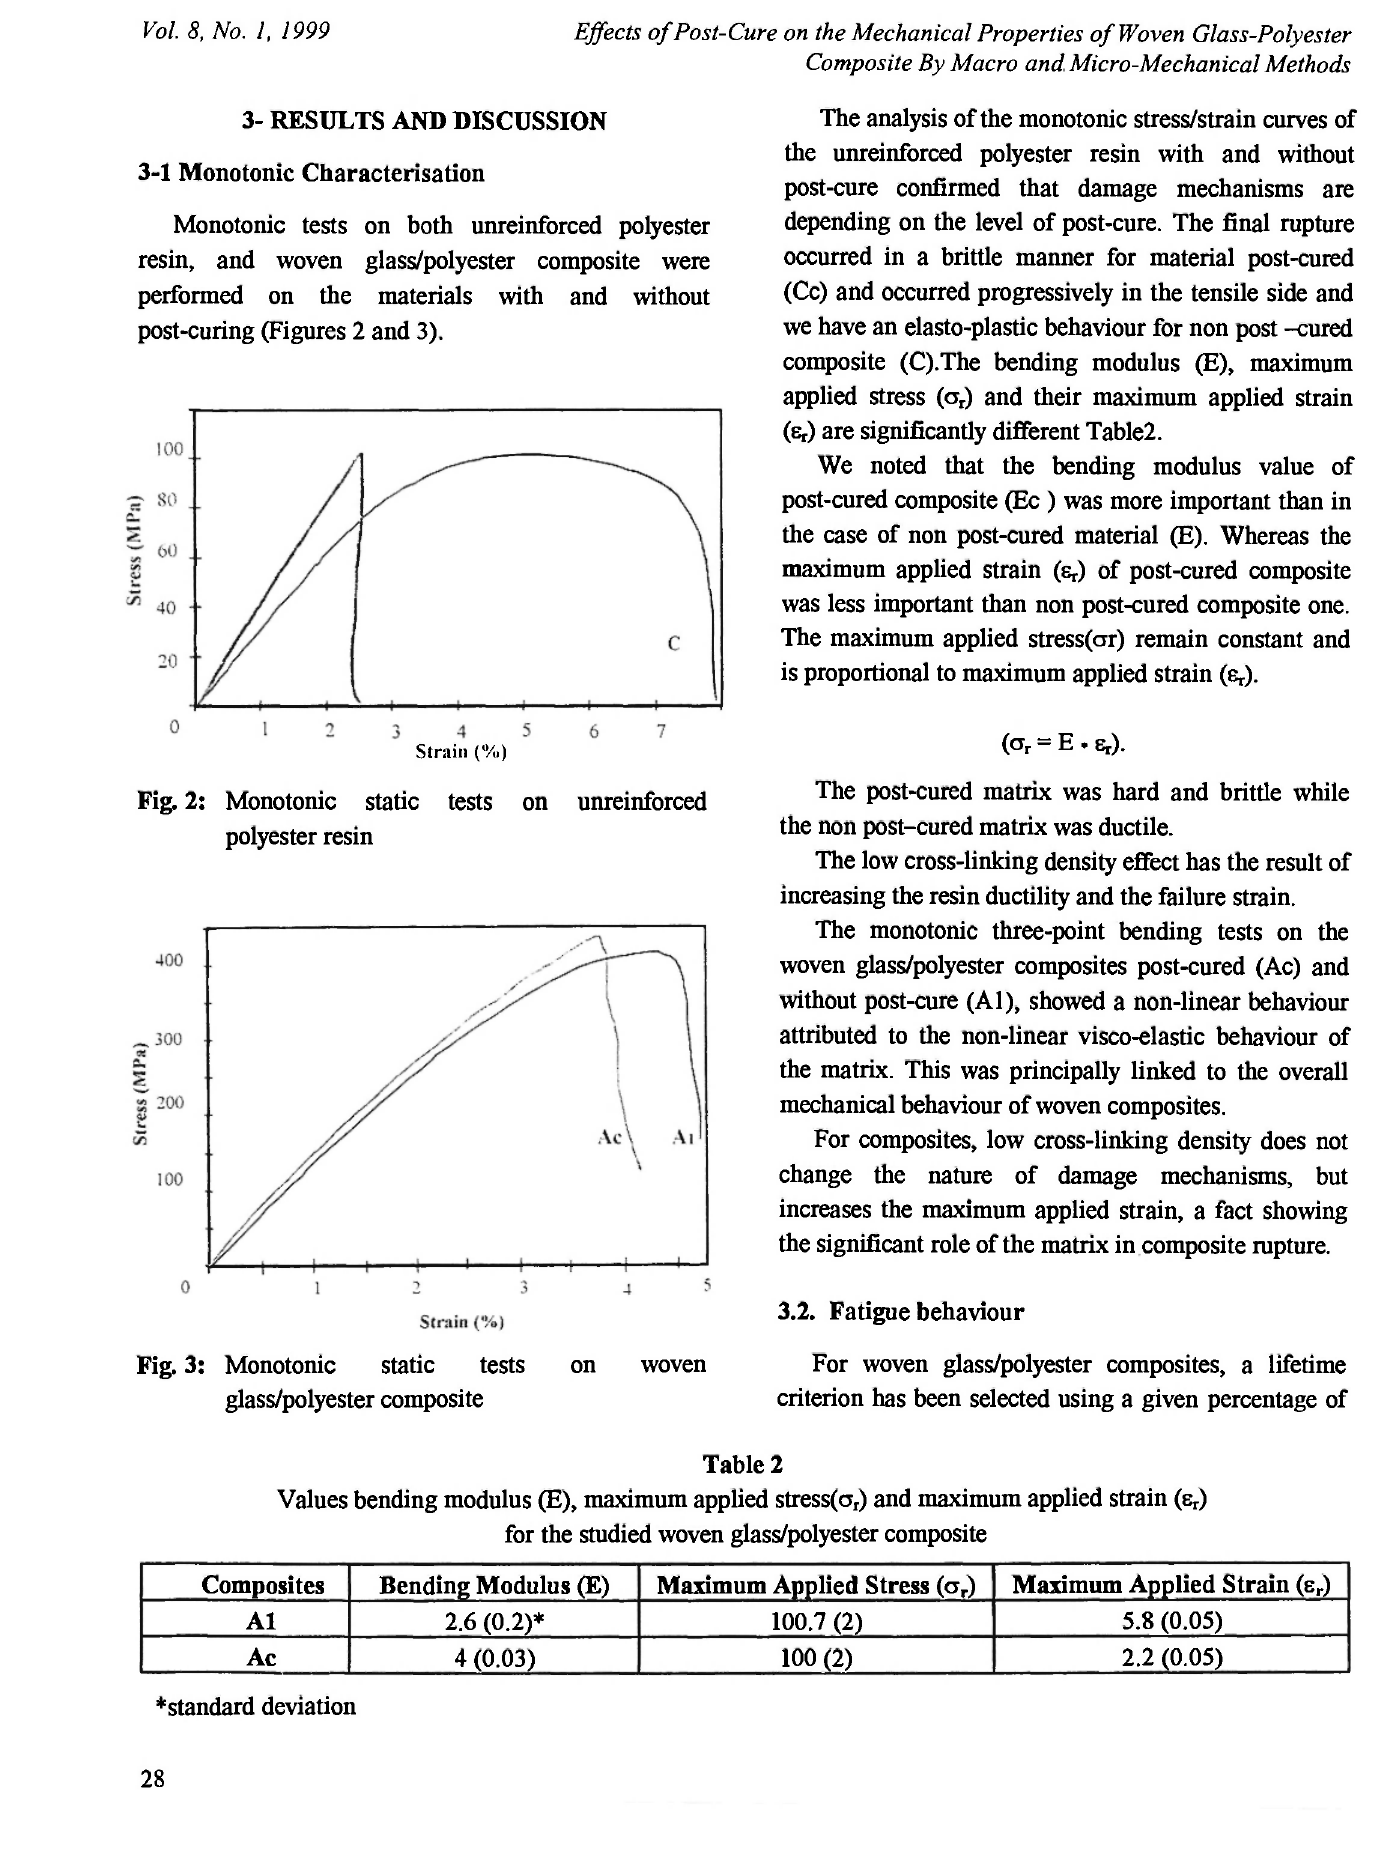
for the studied woven glass/polyester